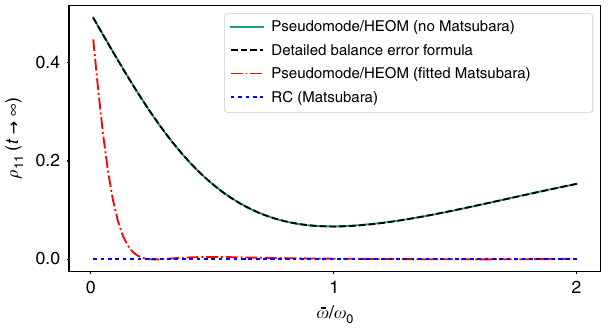
Fig. 2 Correcting detailed balance by including Matsubara frequencies. The probability of the qubit to be excited in the steady-state limit ρ 11 ( t → ∞ ) = 〈 1| ρ ( t → ∞ )|1 〉 as a function of the qubit frequency (cid:2) ω = ω 0 . Here, we choose a weakly coupled broad bath λ = 0.01 ω 0 , γ = ω 0 , i.e., when the qubit should have close to zero excitations in the steady state. The black dashed curve is obtained from the effective inverse temperature β eff in Eq. (7), and it closely fi ts the populations of the qubit using both the pseudomode or HEOM methods without Matsubara corrections (turquoise solid curve). This nonzero temperature arises precisely because of the the neglect of the Matsubara terms. The red-dashed-dotted curve shows the results obtained from including the Matsubara terms in the HEOM and pseudomode methods (the results are identical), while the blue double-dashed curve is from the full RC model. We can see that, for the HEOM and pseudomode results, detailed balance is restored up to a residual error from the fi t, which, however, can become substantial for small qubit splittings (while the RC model obeys detailed balance by construction). Note that if λ is increased, the detailed balance condition in terms of the bare qubit Hamiltonian is not expected to hold in any case, and a more careful error analysis must